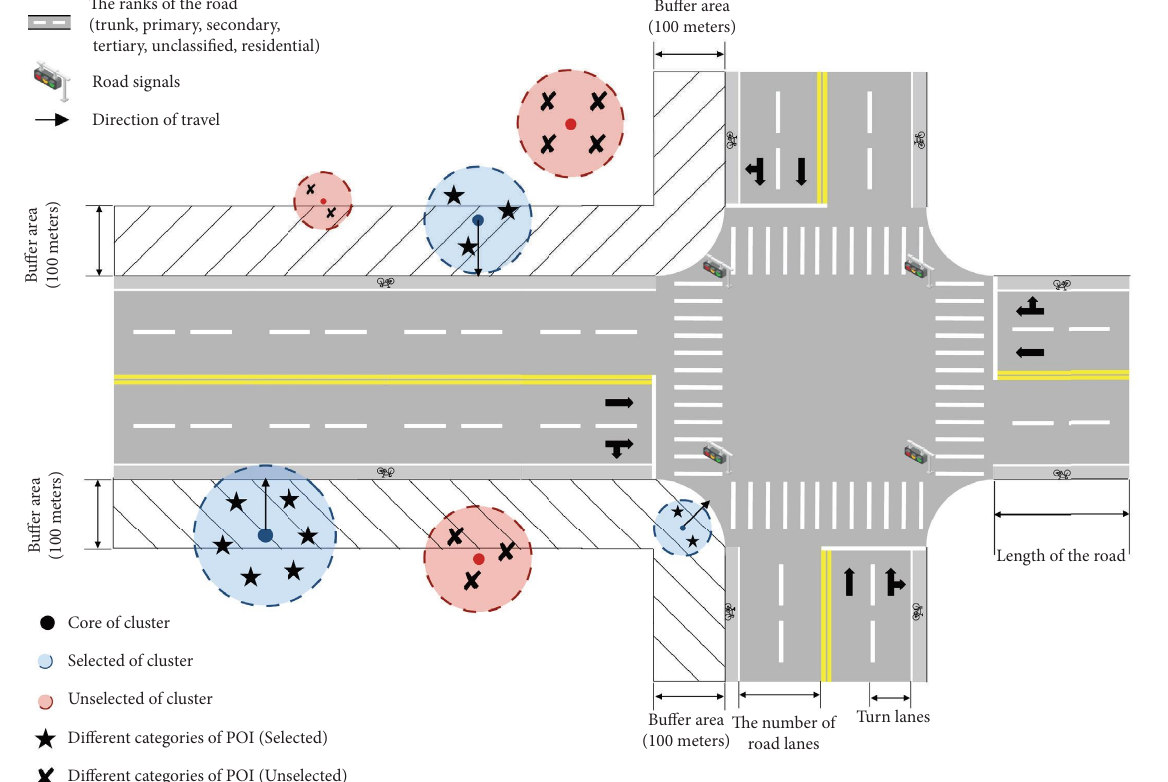
Figure 5: A bufer area of POIs was selected. Diferent types of POI are distributed on the roads. By using the DBSCAN clustering algorithm (Appendix B) based on the Euclidean distance between the POIs to cluster the POIs acquire the core of the cluster. In addition, by setting a boundary (100m) for fltering the core points of the clusters (the bufer area’s scale is not the actual situation). Te blue and red circles correspond to the selected and unselected clusters, respectively. Te star and error symbols indicate POIs selected and POIs unselected, respectively. Finally, the function of the road will use the types of the retained clusters and the scale of POIs in those clusters to